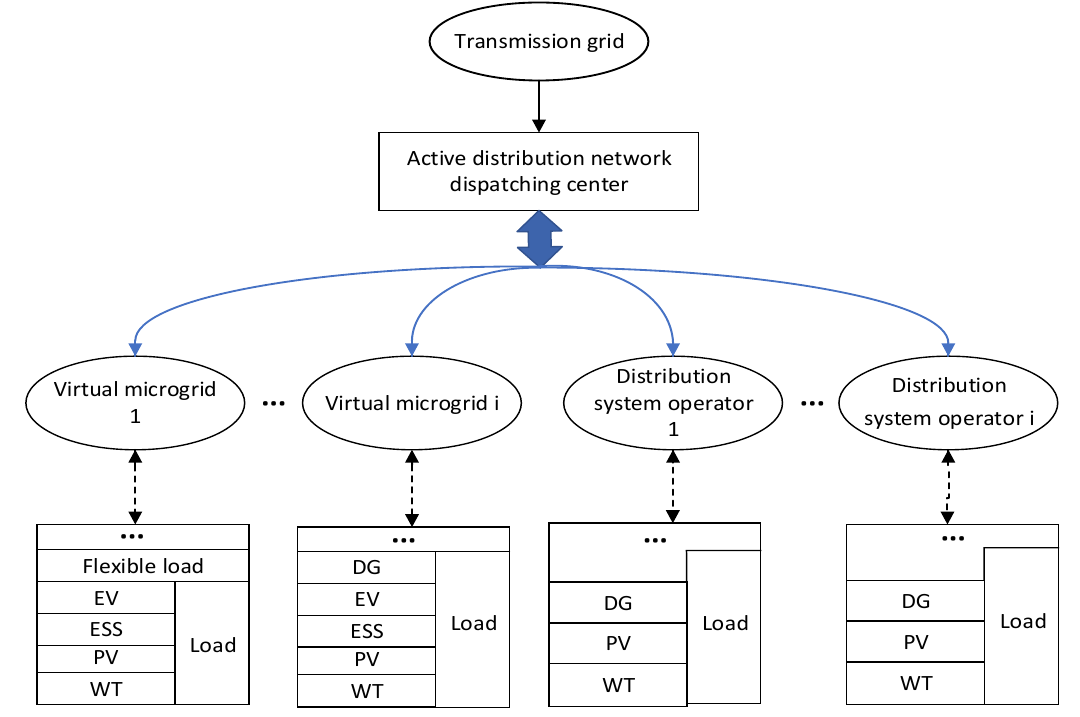
Figure 1. Schematic diagram of active distribution system framework considering the benefits of multi-stakeholder.